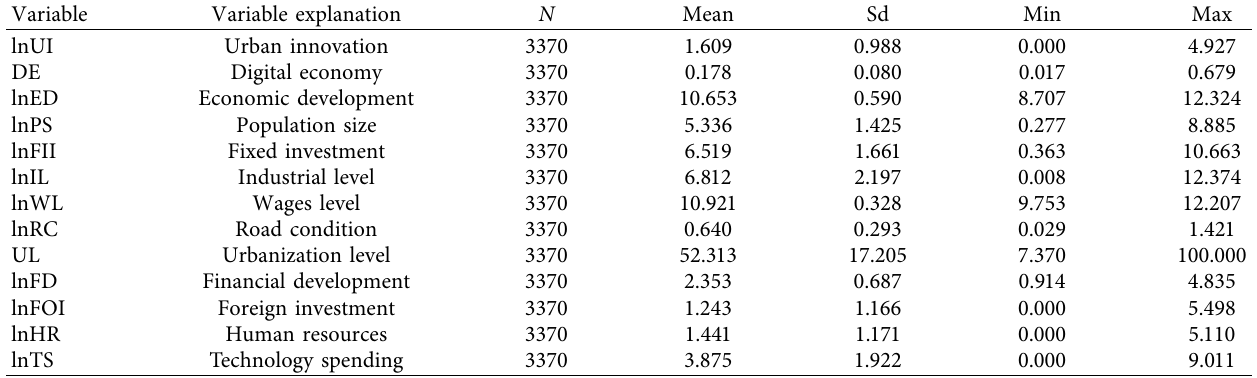
Table 1: Results for the descriptive statistics of variables.